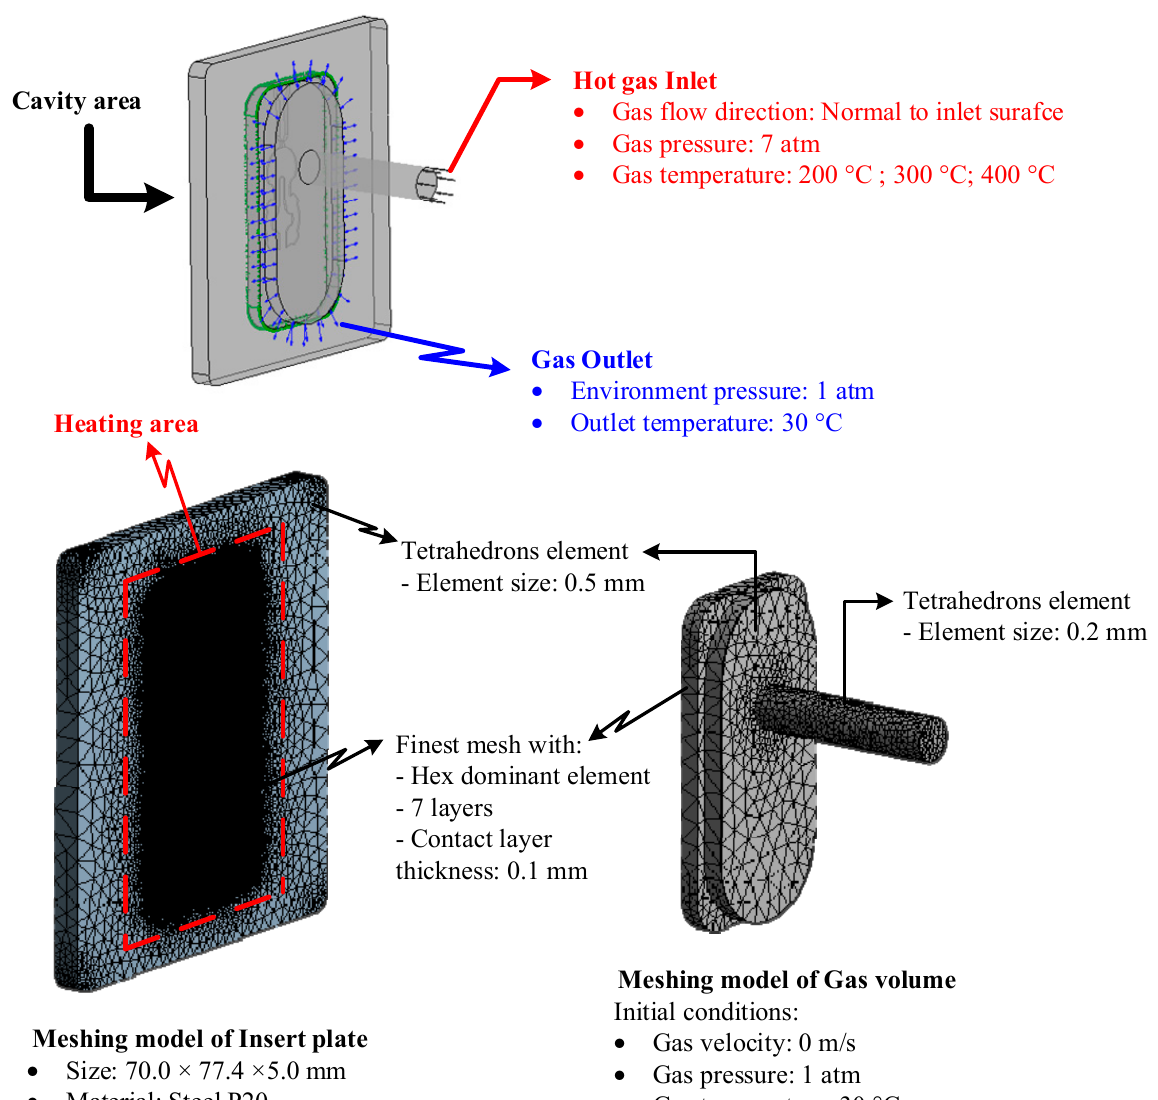
Figure 7. Simulation model and boundary conditions.